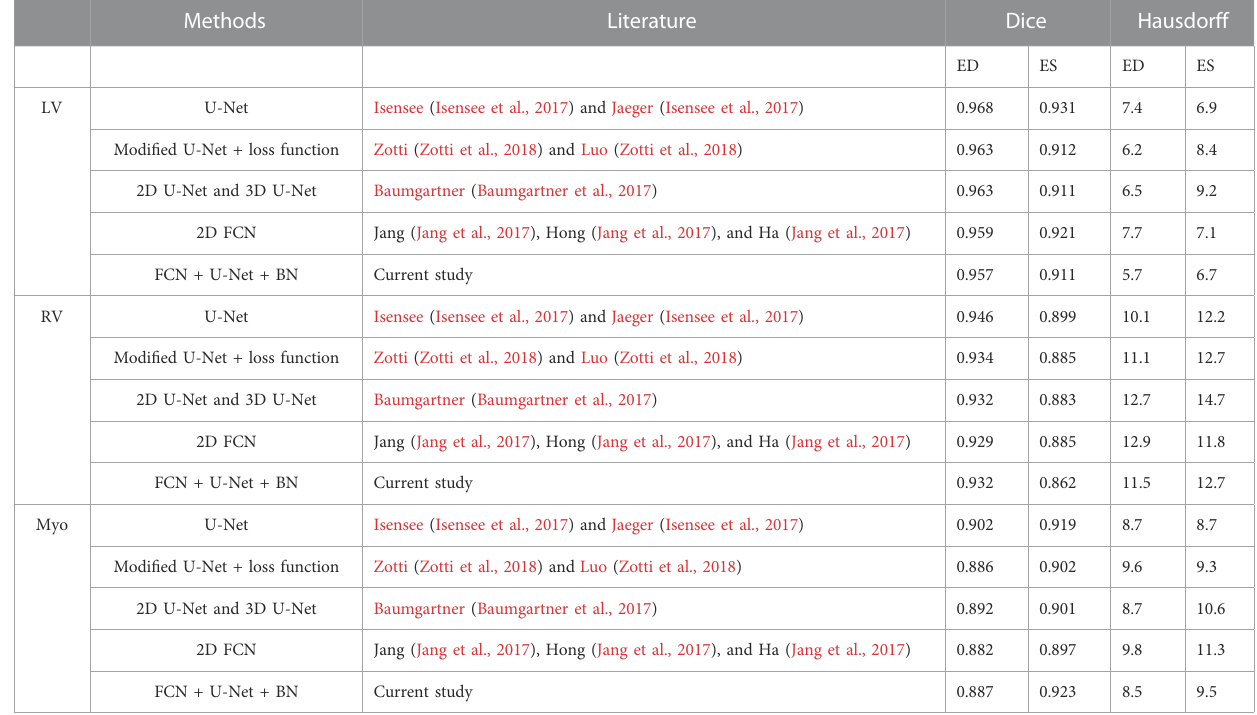
TABLE 3 Segmentation accuracy statistics of different segmentation